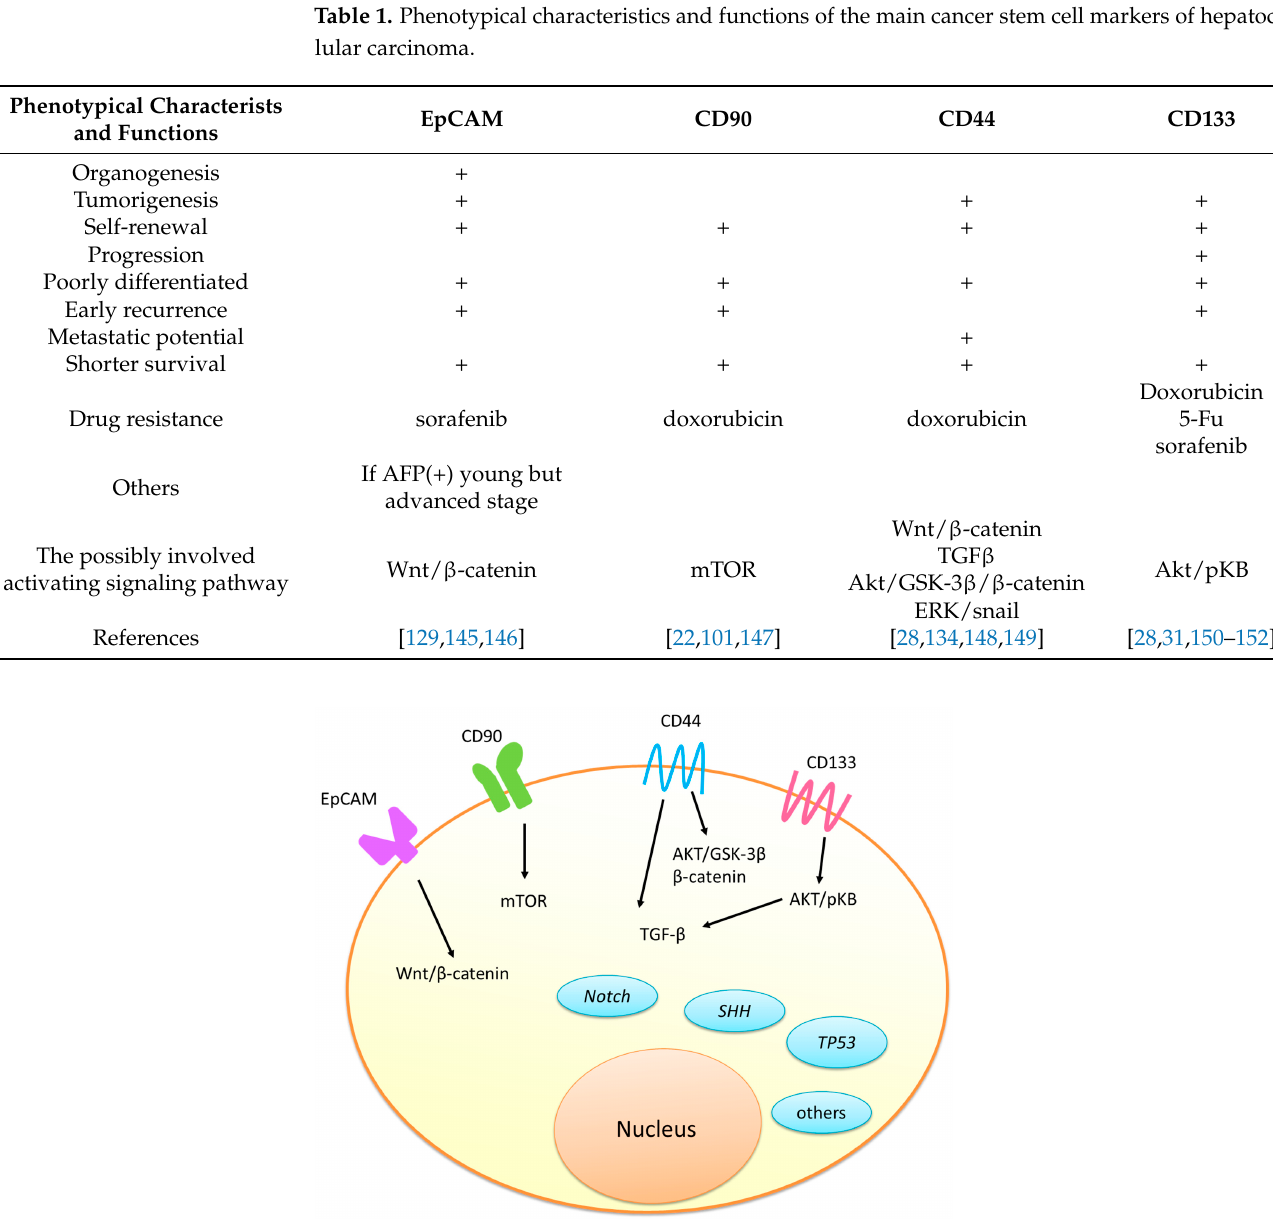
Figure 1. Signaling pathways involved in the cancer stem cells of hepatocellular carcinoma.